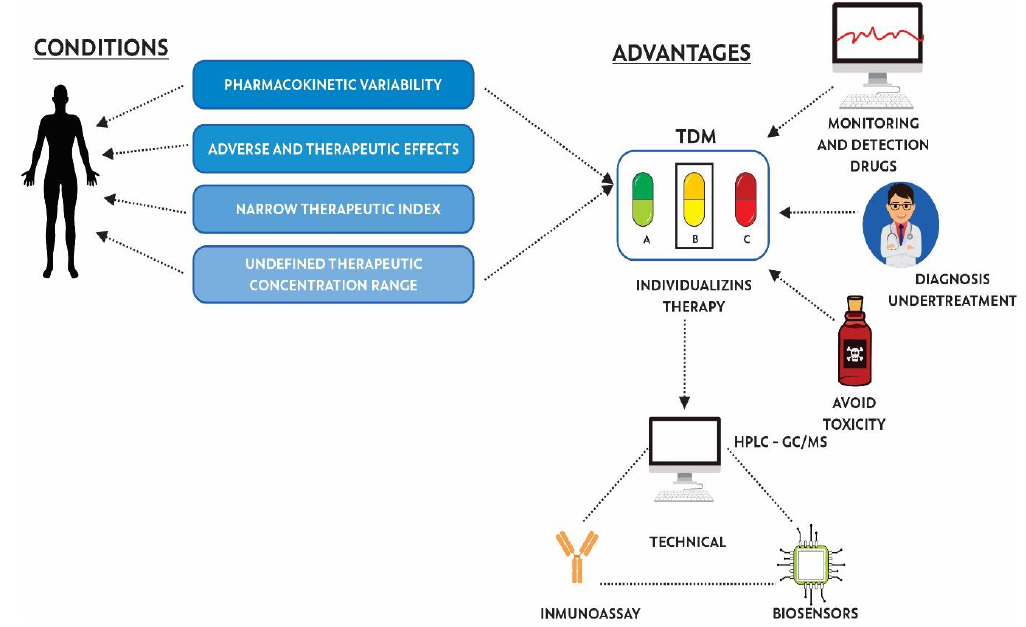
Figure 2. Conditions, advantages, and techniques used for the implementation of therapeutic drug monitoring